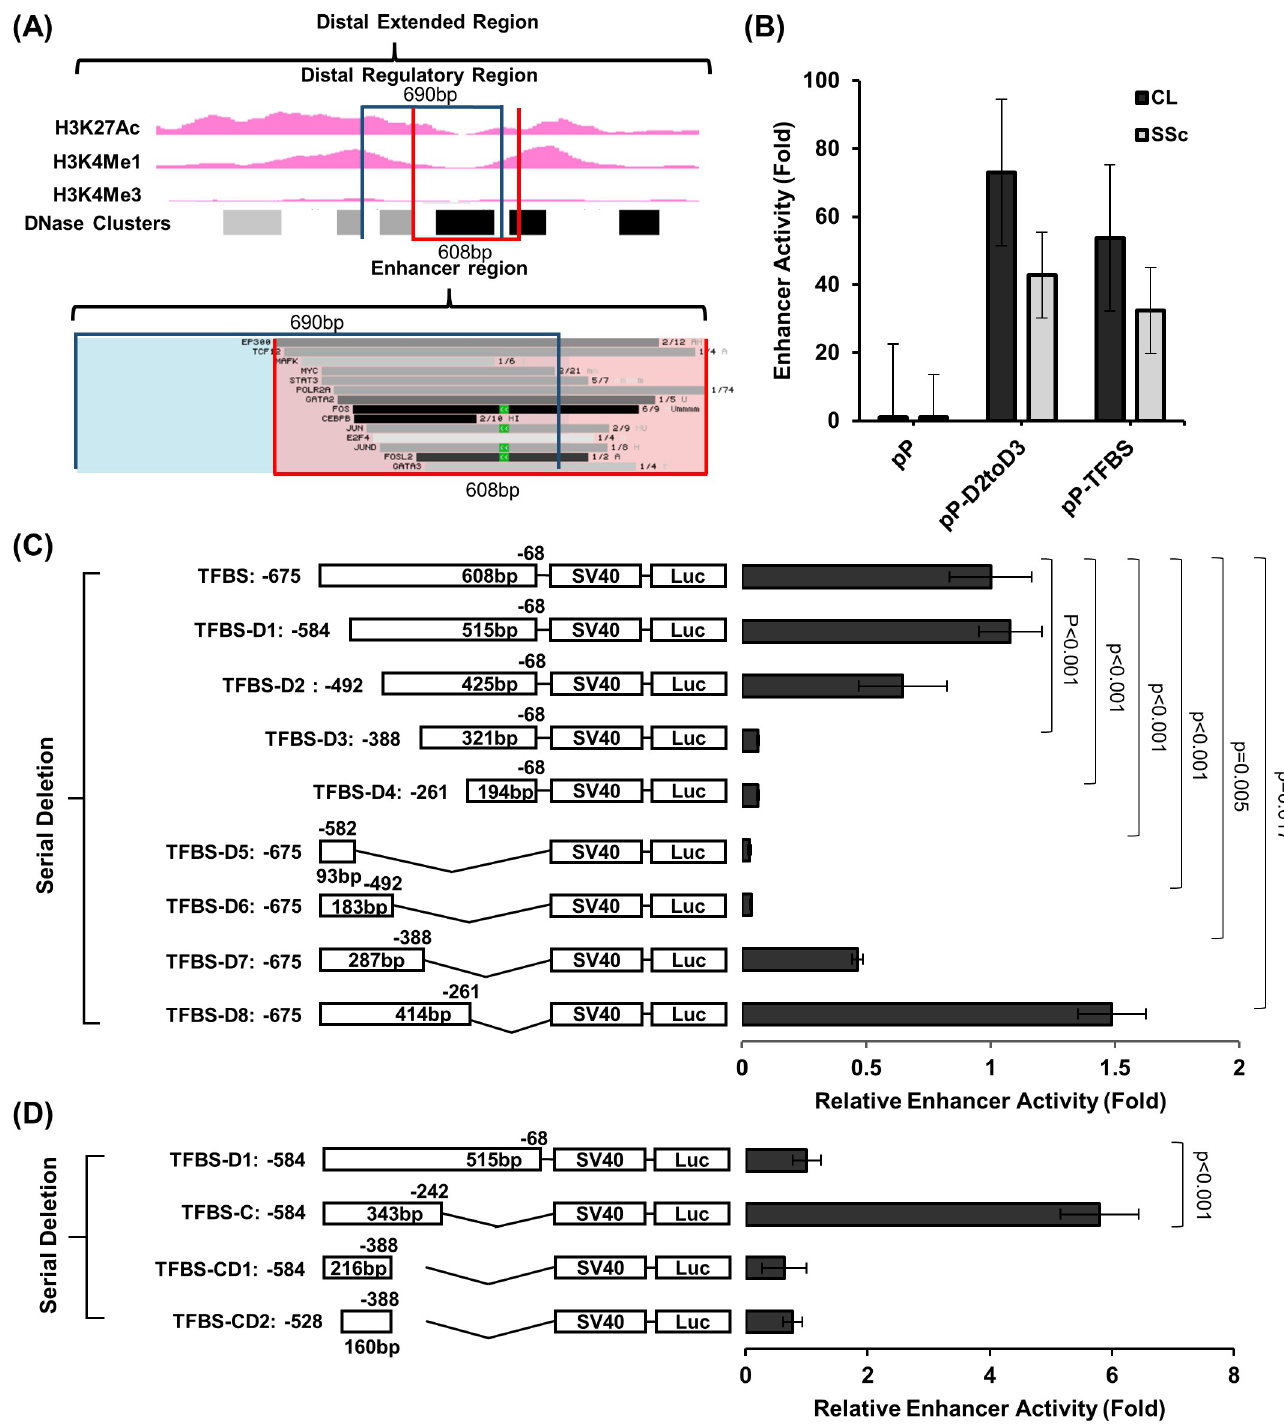
Fig 3. Fine mapping of the distal enhancer. (A) Chromatin characteristics including H3K4Me1, H3K27Ac, H3K4Me3 and DNAse sensitivity clusters for the region flanking the 690bp distal enhancer and the transcription factor binding sites (TFBSs) using UCSC genome browser are shown. (B) Enhancer activity of the 690bp (pP-D2toD3) and 608bp (pP-TFBS) distal enhancer (transfections performed in triplicates) using control and SSc lung fibroblasts with the pGL3promoter (pP) as a control are shown. The promoter activities of pP-D2toD3 and pP-TFBS were tested in 3 control and 3 SSc independent lung fibroblast lines and results from a representative experiment are shown as mean ± standard deviation. (C) and (D) Serial deletion of the 608bp (pP-TFBS) and 515bp (TFBS-D1) distal enhancer are shown. In (C) the deletion plasmids are sequentially labeled as TFBS-D1 to D8 and in (D), they are labelled as TFBS-C and TFBS-CD1 to CD2. Transfections were performed in triplicates. Relative enhancer activities are calculated by obtaining the fold change using pP as a control for each deletion